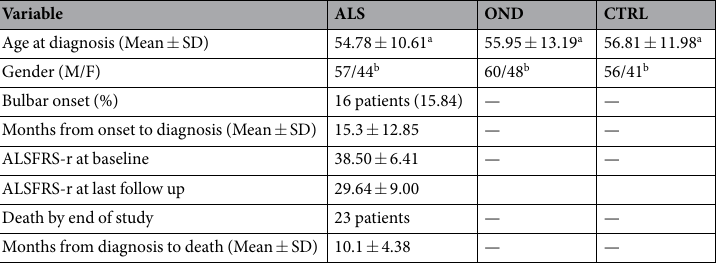
Table 1. Demographic Characteristic of ALS, OND and CTRL. a and b : there was no difference in age or gender among three groups (p >